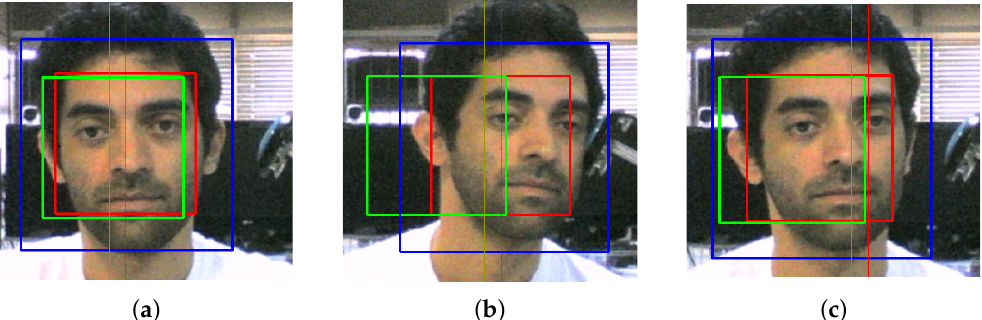
Figure 1. Illustration of head tracking and threshold-based movement classification. The green rectangle represents the reference position, denoted by s h 0 and p h 0 , while the red rectangle illustrates the current estimated position. ( a ) illustrates the initial position, ( b ) the definition of a position threshold x t (yellow line) based on max ( x h ) (red line), and ( c ) the user moving his head to control the virtual